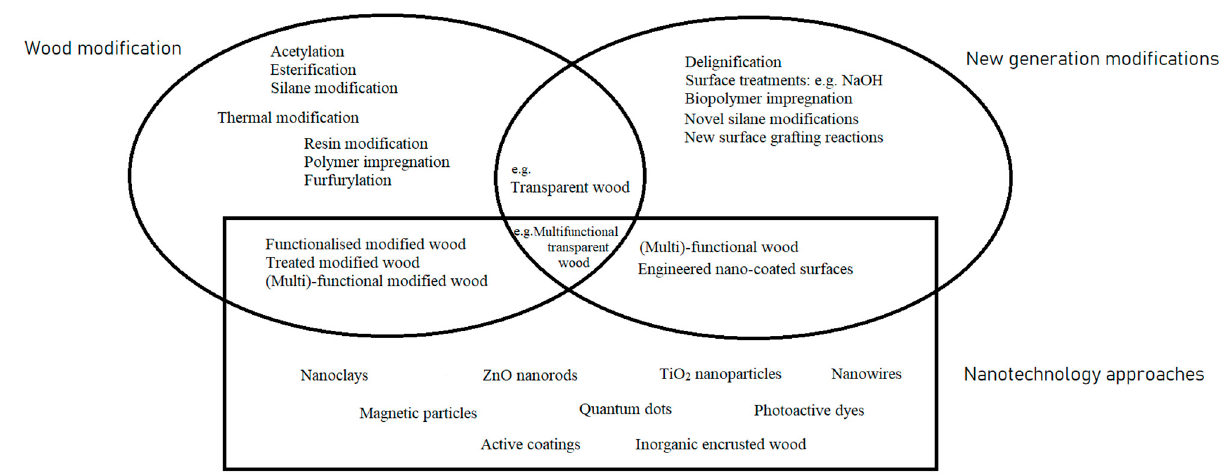
Figure 1. Interaction of wood modification and nanotechnology to create functional and multi-functional wood.